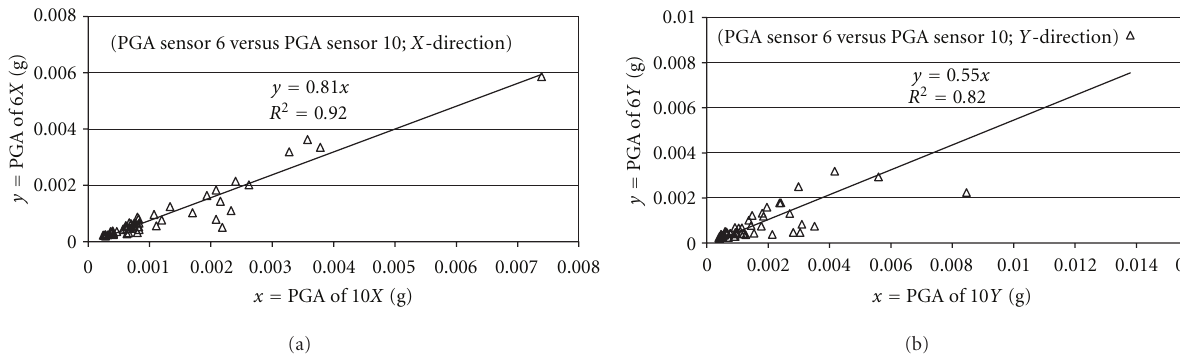
Figure 5: PGA at base of building A recorded by sensor 6 versus PGA at free field recorded by sensor 10: (a) X -direction and (b) Y -direction.